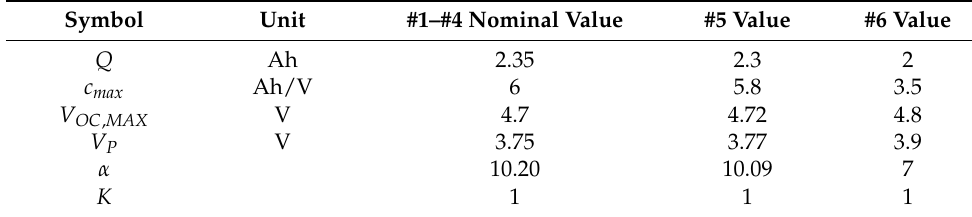
Figure 11. 18,650 Ternary battery ( a ) SOC –VOC curve and ( b ) C max –VOC curve. Table 4. Parameters for ternary batteries.